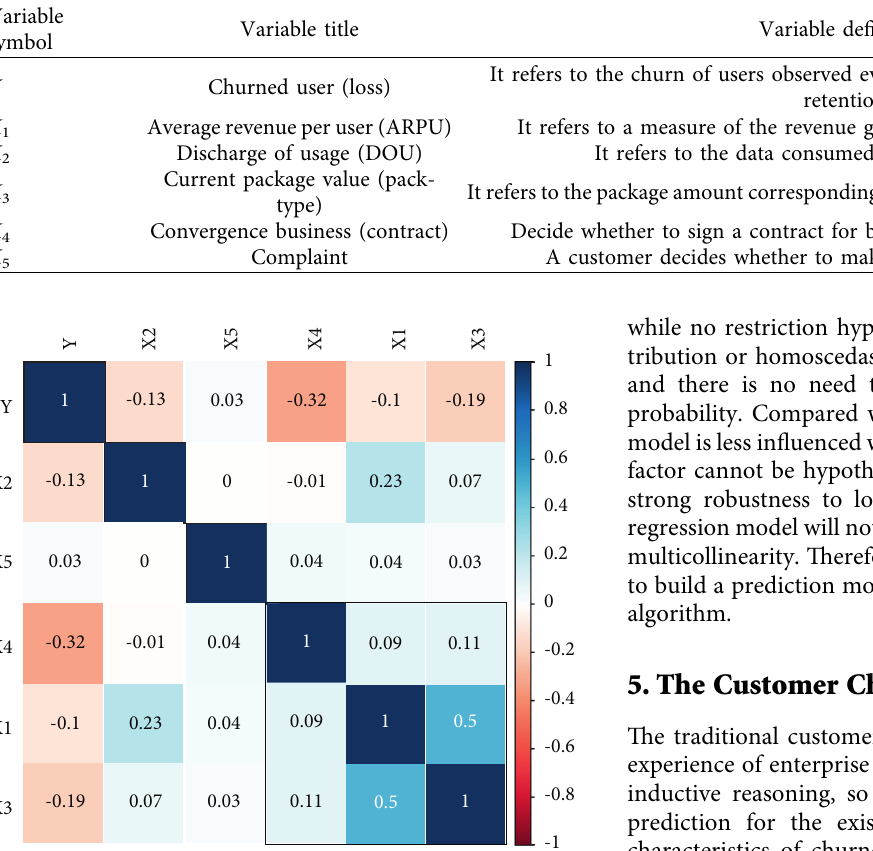
Figure 1: Correlation